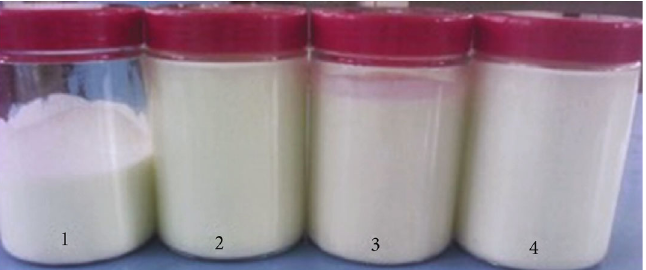
Figure 1: The four types of plain stirred forti fi ed yoghurt. These included banana (1), passion (2), strawberry (3), and mango (4) fl avors, respectively.